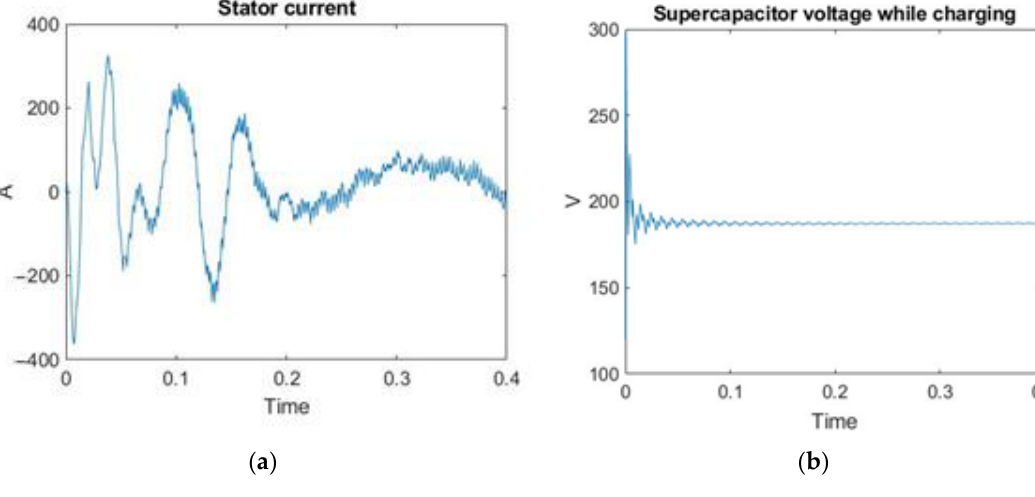
( c ) Figure 11. Charge of the supercapacitor: ( a ) current; ( b ) voltage and ( c ) state of charge. When the supercapacitor unit is charging, it consumes a voltage of 170 V, which is the total voltage of this unit calculated above, consisting of 10 supercapacitors connected in series. When 100% of the SOC% charge of the supercapacitor is reached, the control